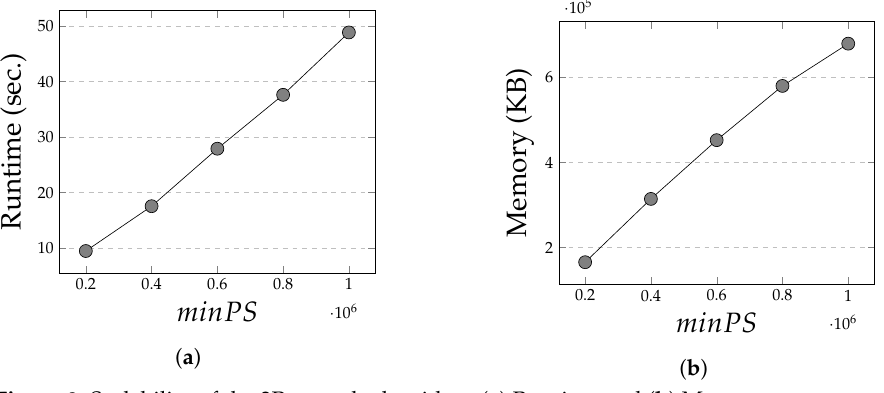
Figure 8. Scalability of the 3P-growth algorithm: ( a ) Runtime and ( b )